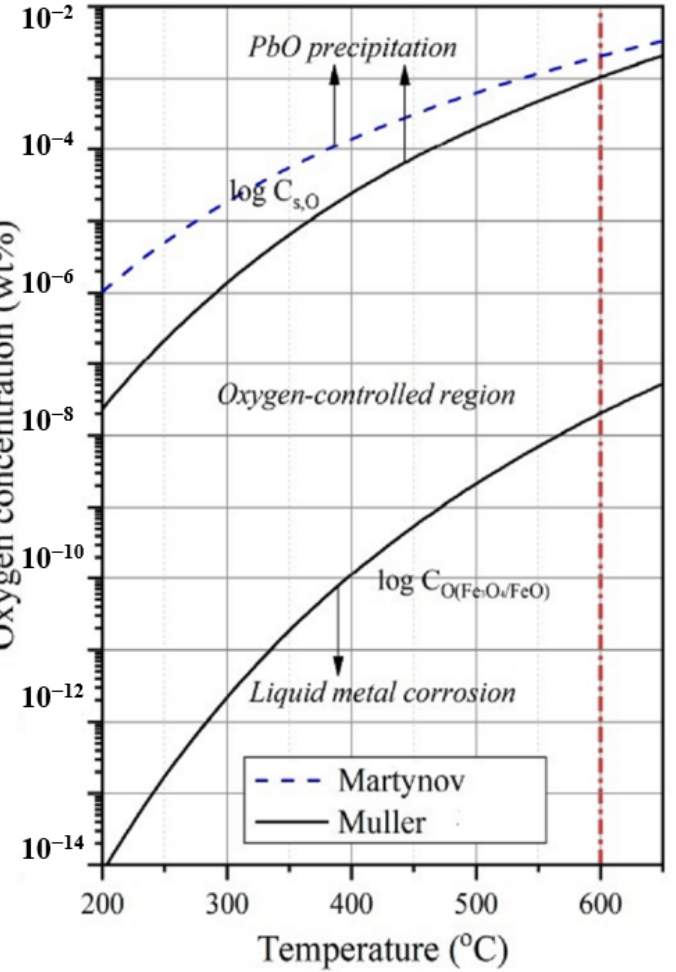
Figure 1. Conditions of lead oxide and protective films formation according to Martynov [17] and Müller [18]. The red line indicates the maximum core temperature for currently designed reactors with LBE